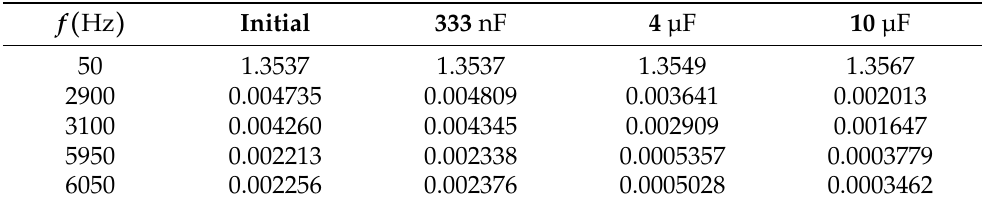
Table 2. Radial flux density harmonics in the air gap B δ hr (